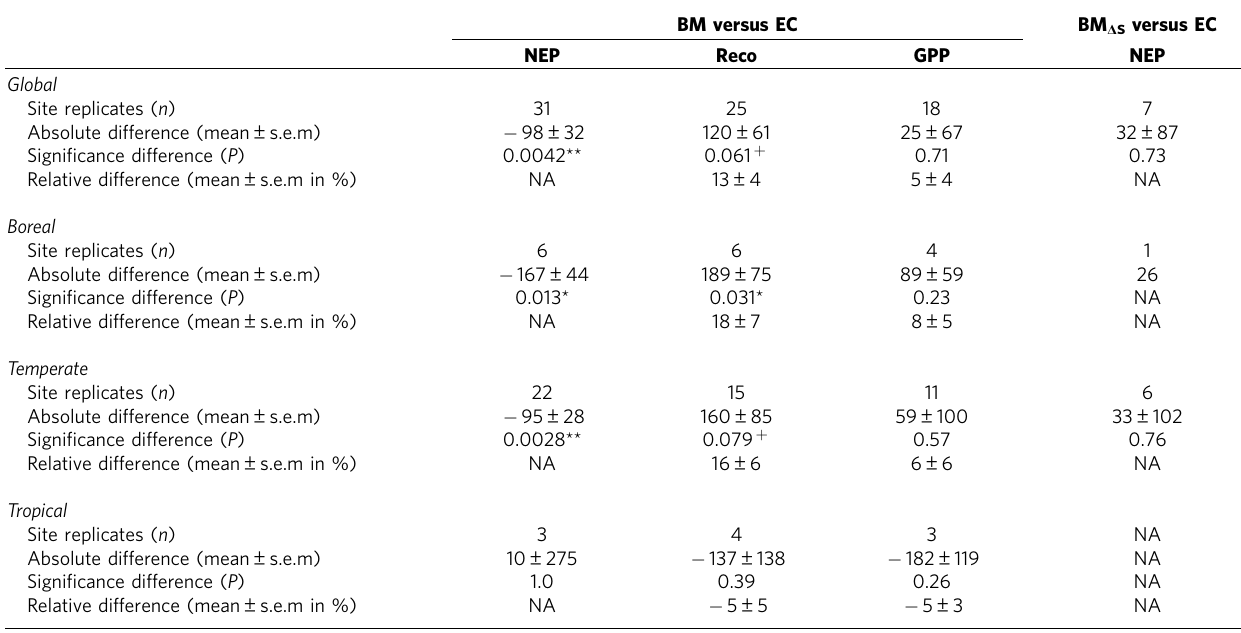
Table 2 | Comparison of carbon fluxes obtained from eddy-covariance or biometric methods for forests worldwide and in the main climatic zones.